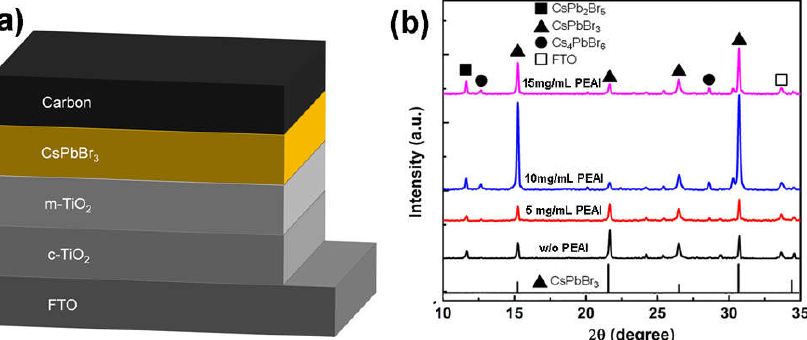
Figure 1. ( a ) Schematic structure of CsPbBr3 PSCs; ( b ) XRD patterns of CsPbBr 3 films without and with PEAI doping in different concentrations.